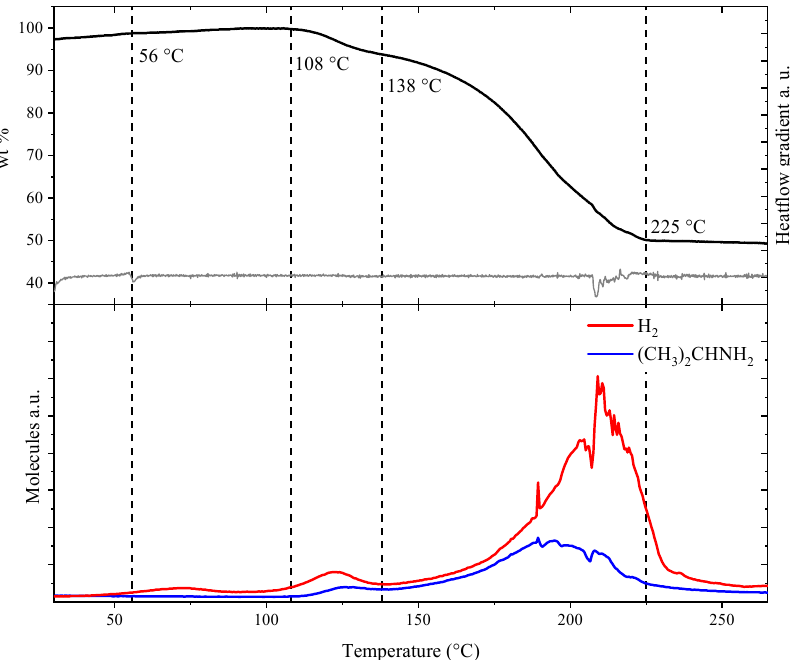
Figure 5. Simultaneous measurement of thermogravimetry (TGA), differential scanning calorimetry (DSC) and mass spectroscopy (MS) of Mg(BH 4 ) 2 ∙ IPA ( s3 ). ( Top ) TGA data and the gradient of the differential scanning calorimetry data. ( Bottom ) MS analysis of hydrogen and isopropylamine release.